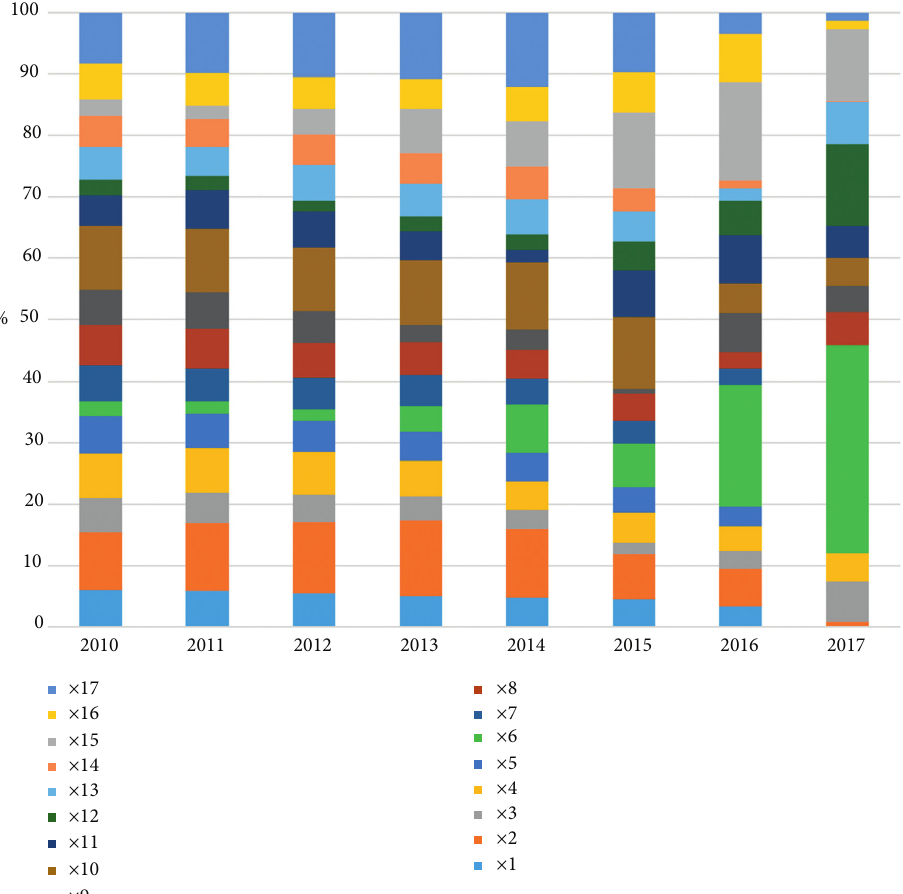
Figure 9: The degree of obstacle factors for coupling coordination development of central cities in the Yellow River Basin. X1–X17 presented factors in the index system in Table 1.